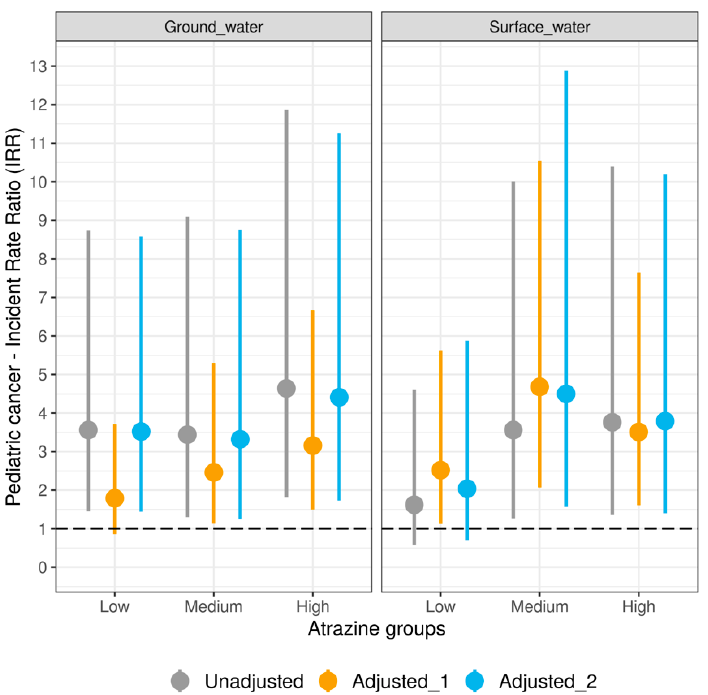
Figure 2. Association between atrazine concentration and pediatric cancer. This figure contains the incidence rate ratio (IRR) and 95% confidence interval to describe the association between atrazine and pediatric cancer. Ground and surface represent the water sample source, categorized into four quantile groups. The IRRs were estimated for Low, Medium, and High atrazine categories comparing with the negligible atrazine category (reference group). The associations were evaluated using three models unadjusted (grey), adjusted_1 (yellow), and adjusted_2 (cyan). Note: The IRR and 95% confidence interval were estimated using a generalized linear model assuming a negative binomial distribution, with population per watershed as an offset term. The IRRs with confidence interval that interest the dashed line (corresponding to “1” on the y -axis) is non-significant.